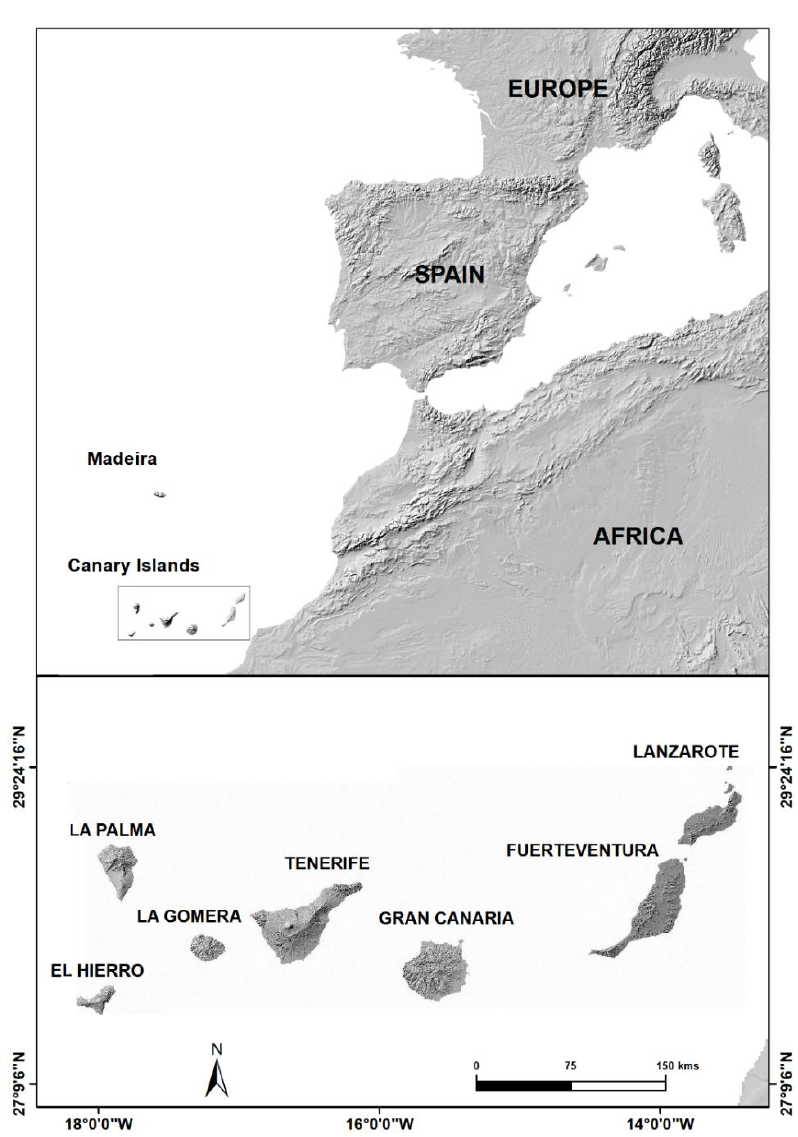
Figure 1. Location of Canary Islands. Sources: https://www.diva-gis.org/gdata and https://www.diva-gis.org/gdata and http://centrodedescargas.cnig.es, self-elaboration.